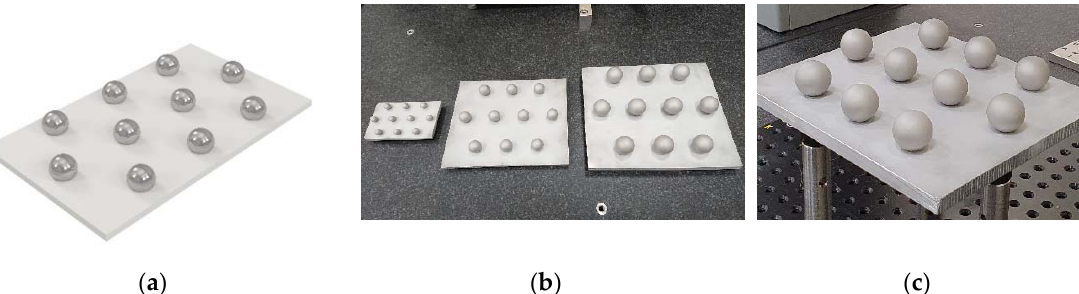
Figure 4. Sphere sets: ( a ) plate of 10 pre-sandblasted spheres (only the support plate has been sandblasted to avoid reflec- tions); ( b ) general view of the 3 plates of 10, 18 and 25 mm diameter spheres; ( c ) detail of the plate with 25 mm post-sandblasting spheres.